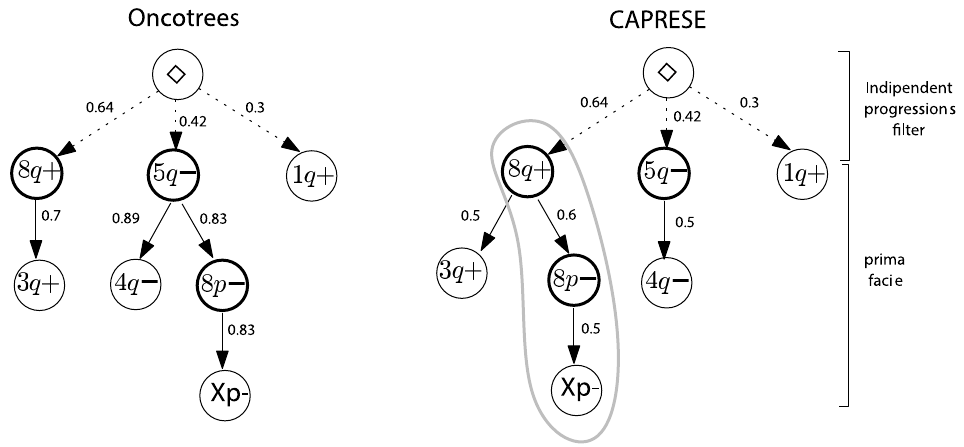
Figure 7. Reconstruction of ovarian cancer progression. Trees reconstructed by oncotrees and CAPRESE (with l ? 0 , with l ~ 1 = 2 the same tree is reconstructed). The set of CGH events considered are gains on 8 q , 3 q and 1 q and losses on 5 q , 4 q , 8 p and Xp . Events on chromosomes arms containing the key genes for ovarian cancer are in bolded circles. In the left tree all edge weights are the observed probabilities of events. In the right the full edges are the causation inferred with the PR and the weights represent the scores used by CAPRESE. Weights on dashed lines are as in the left tree.